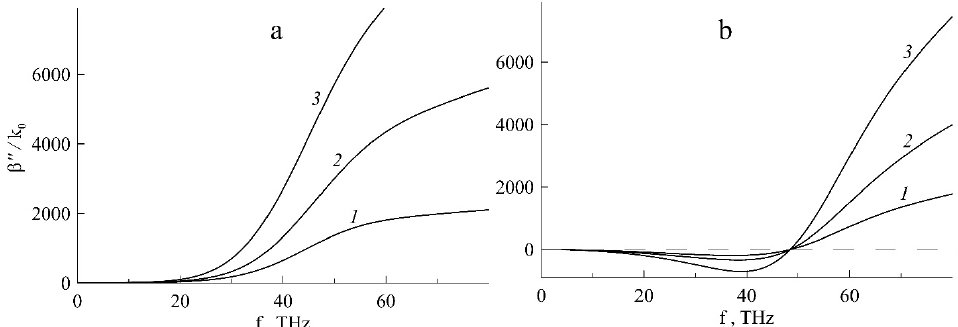
Figure 7. Frequency dependence of the imaginary part of the propagation constant with dif- ferent permittivity of the barrier layer for a structure with doped and inverted graphenes ( a , b ); µ = 0; 0.02; 0.06; 0.10 eV (dashed curve and curves